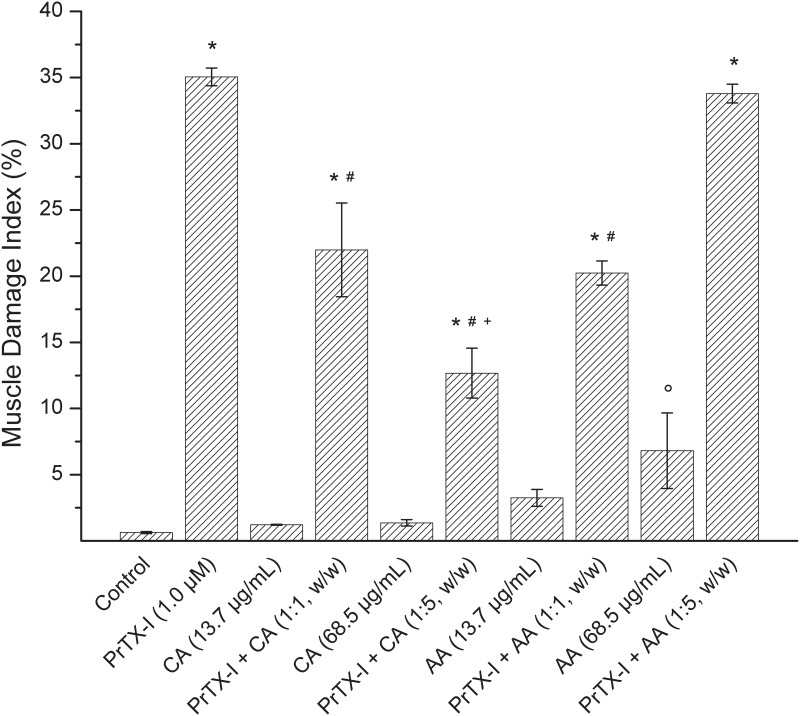
Effect of CA and AA upon the muscle damage index induced by PrTX-I in mouse diaphragm preparations.The ordinate represents the percentage of damaged fibers relative to normal fibers and the abscissa indicates the experimental groups. The bars are expressed as the mean ± S.E. * indicates when differences between PrTX-I treatments (alone and pre-incubated with CA or AA) and their respective controls was significant. # indicates when there were significant differences between PrTX-I pre-incubated with inhibitors and PrTX-I alone treatments. + indicates significant differences between PrTX-I treatments pre-incubated with CA. ° indicates significant differences between the AA (68.5 μg/mL) treatment and the Control group.